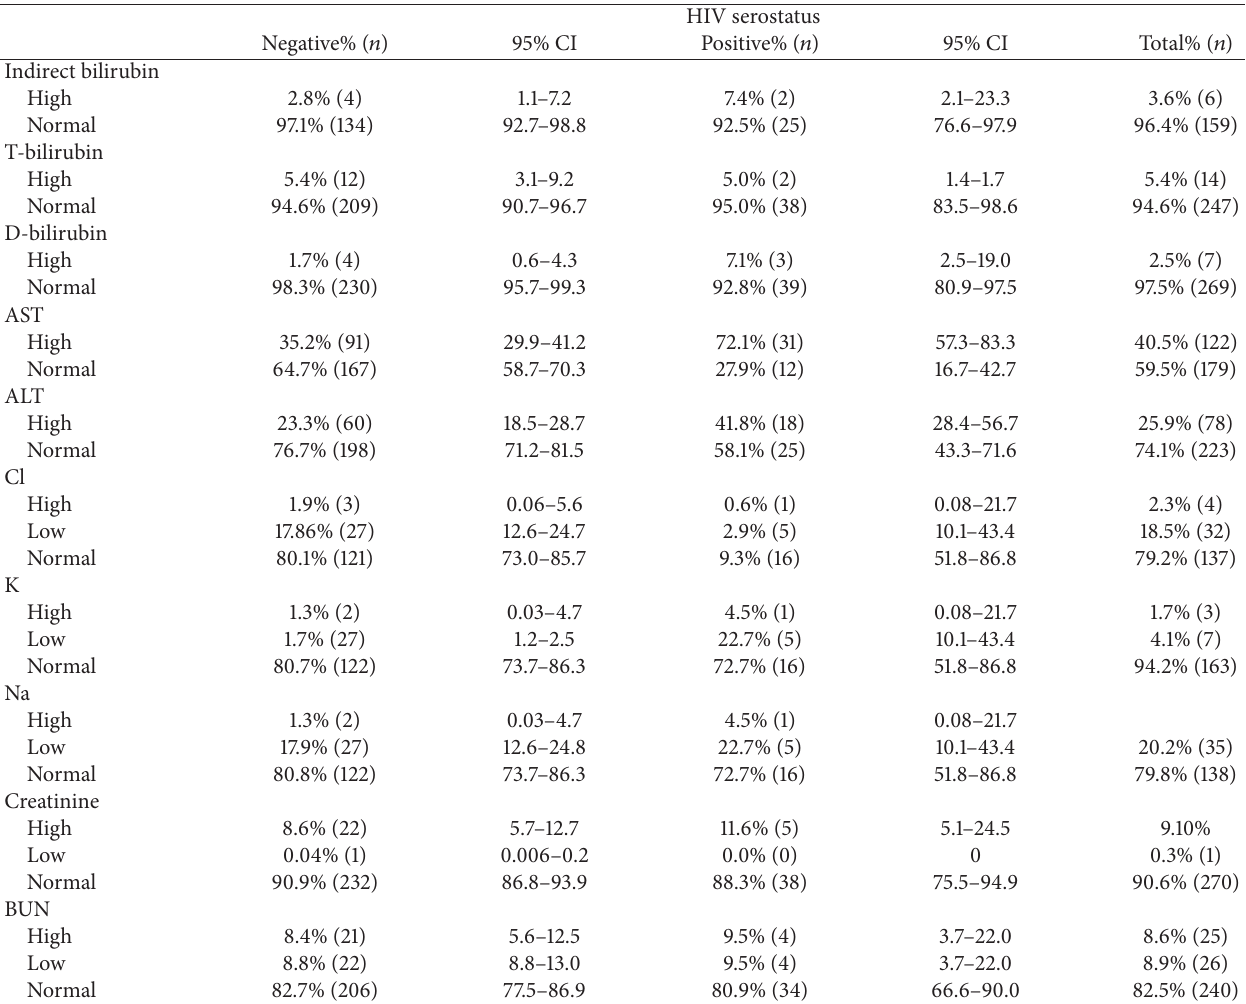
Table 5: Mean and SD of biochemistry parameters among TB and TB-HIV patients.